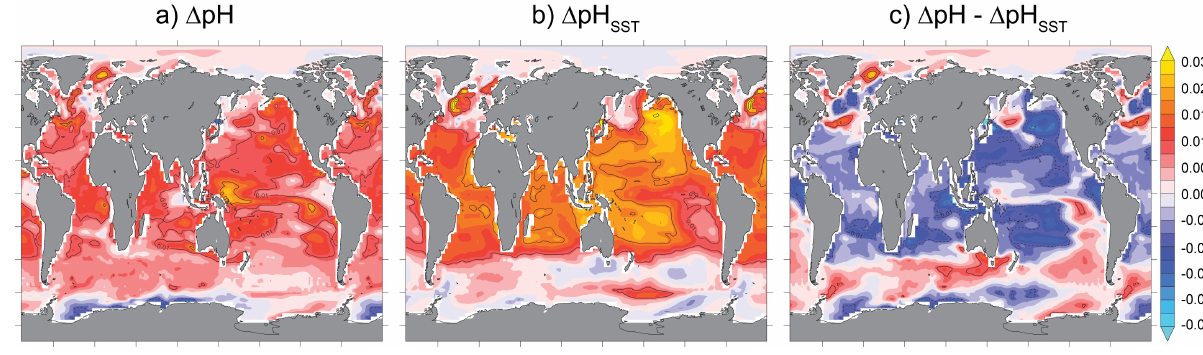
Fig. 9. Difference pattern between the Pin.10x case and the control simulation averaged over the first 5yr: (a) pH changes, (b) pH changes due to changes in SST only and (c) pH changes not caused by SST